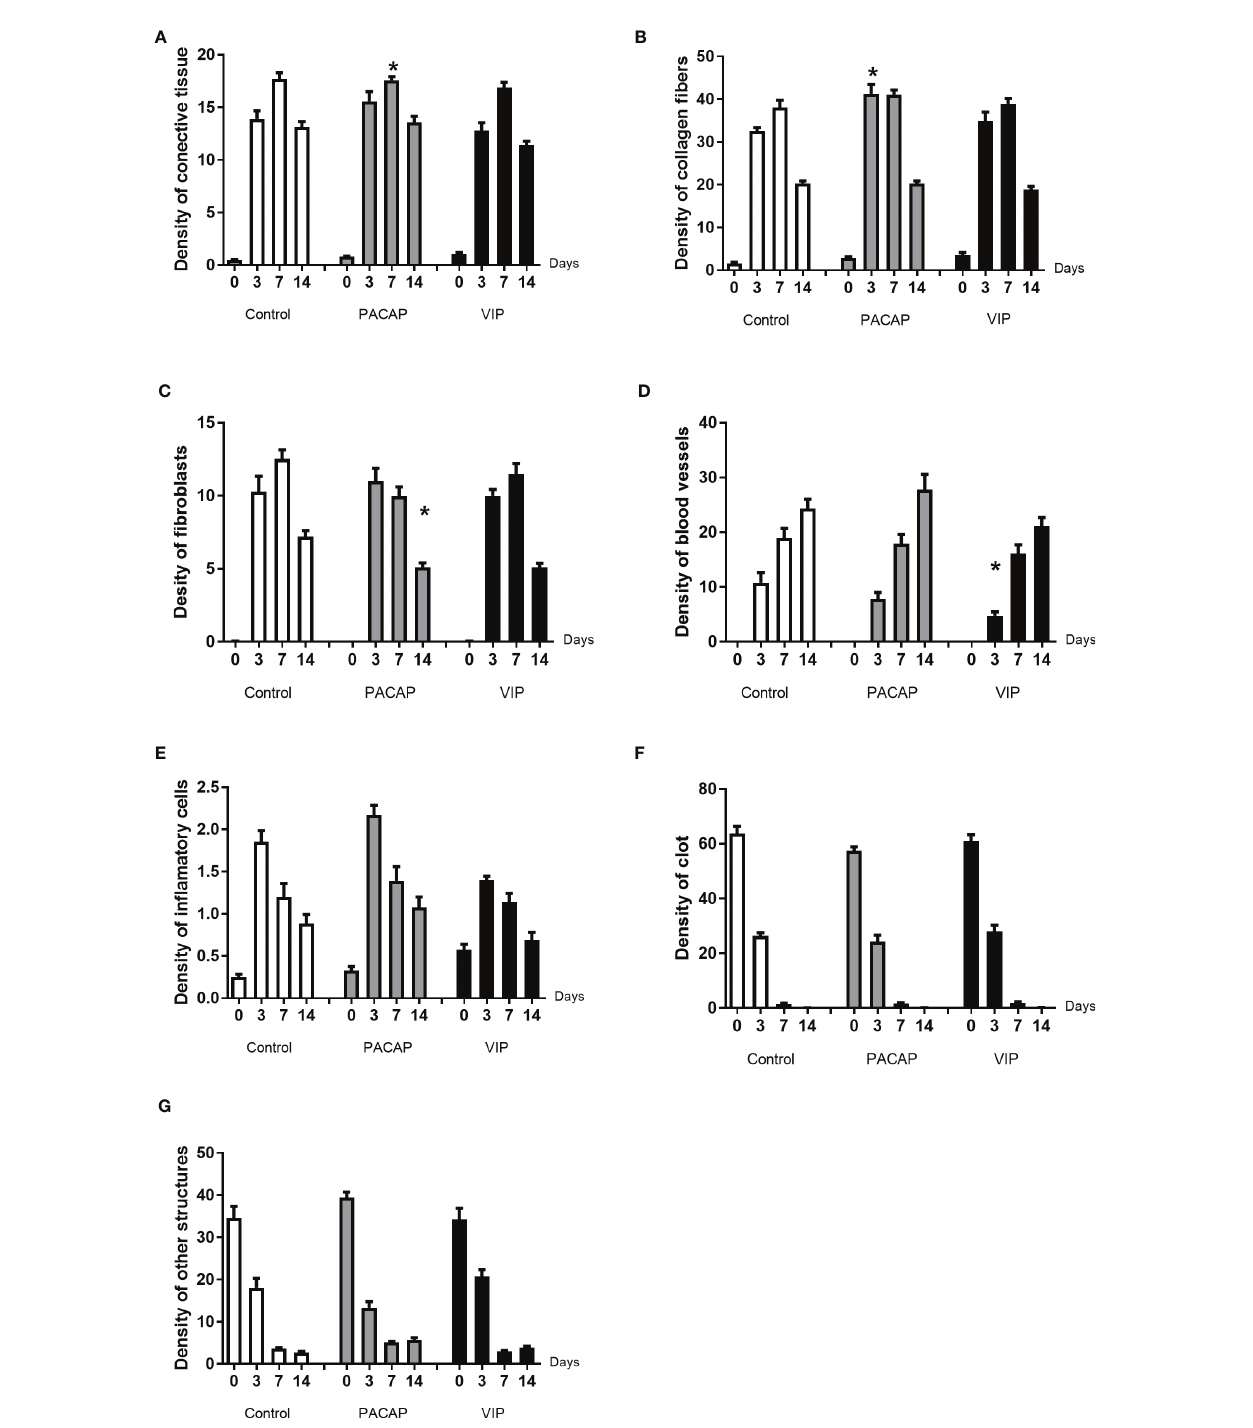
FIGURE 8 | Comparative density analysis (%) of connective tissue (A) and its components (B – G) present in the dental alveolus of control mice and treated with VIP and PACAP in the 0, 3-, 7-, and 14-day post-exodontia periods. Results are presented as the means of density for each structure of the alveolar socket: collagen fi bers, fi broblasts, blood vessels, in fl ammatory cells, clot and other components (empty space left by intercellular liquid and spaces). Also, the results depict the total density of connective tissue (represented by the sum of collagen fi bers, fi broblasts, blood vessels, and in fl ammatory cells). The results represent the values of the mean and standard deviation in each of the periods analyzed (* represents the differences between the control